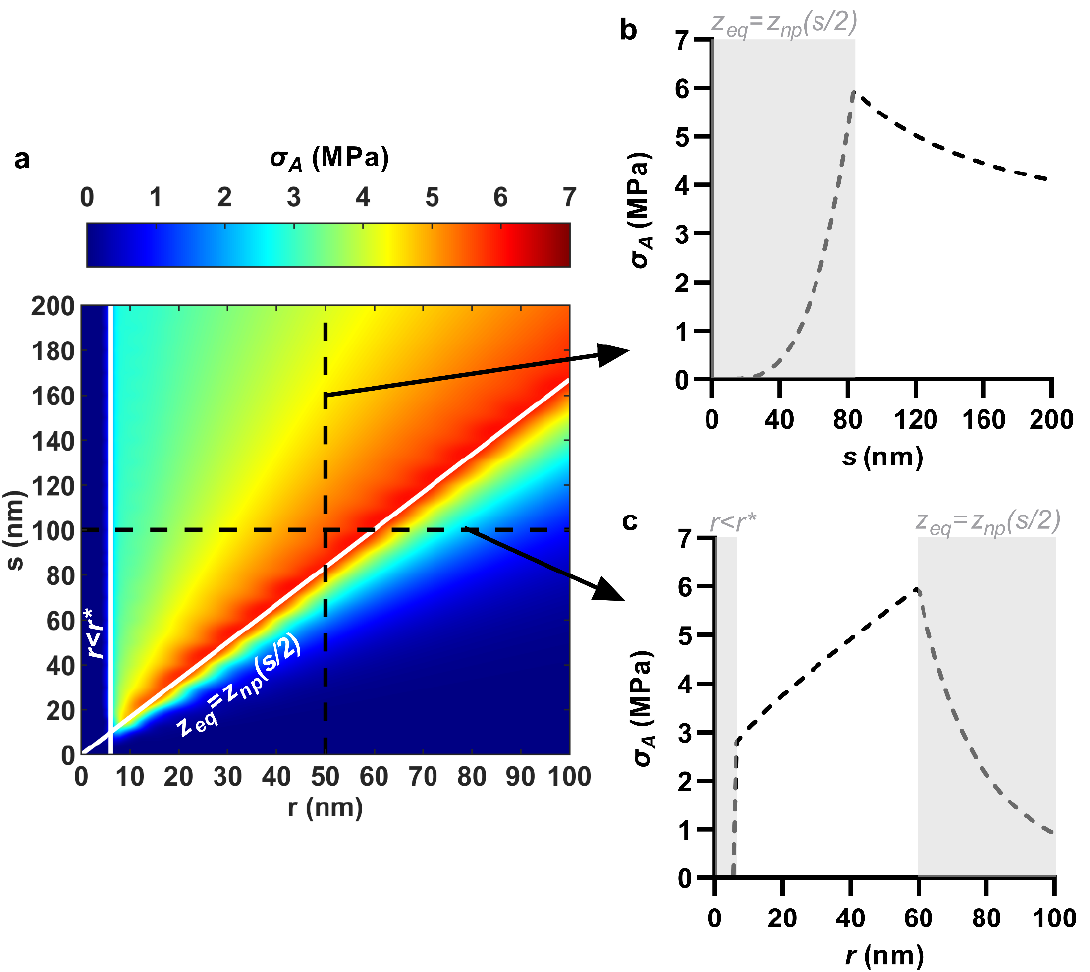
Figure 3. Effect of nanopillar quasi-tip radius, r , and center spacing, s , on envelope areal stress, σ A . ( a ) Combined effects of quasi-tip radius and center spacing shown as a contour plot; ( b ) Selective effect of center spacing, at a fixed quasi-tip radius of 50 nm; ( c ) Selective effect of quasi-tip radius, at a fixed center spacing of 100 nm. r < r* and z eq = z np ( s /2) indicate discontinuities due to emergence of a bending energy barrier and closing of interspace, respectively. For all cases, nanopillar height, pattern ordering, and work of adhesion were 200 nm, hexagonal and 20 mJ/m 2 , respectively.